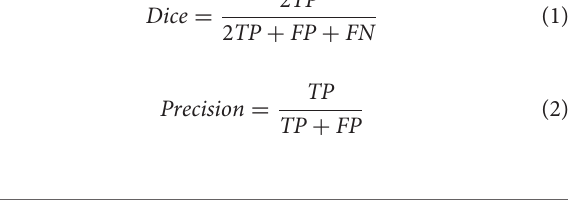
TABLE 4 | Summary of lesion characteristics for ISLES 2017 Data.